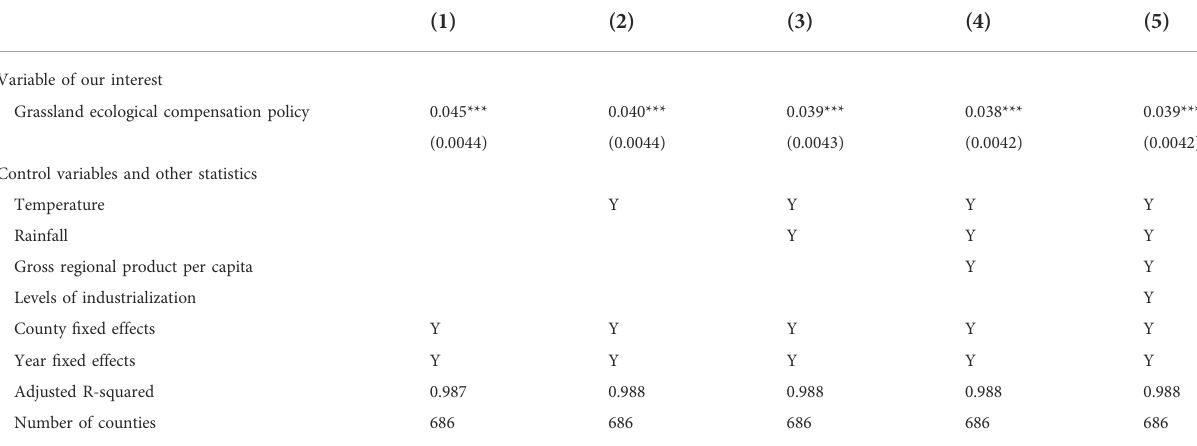
TABLE 1 Estimates in the impact on grassland quality from difference-in-differences